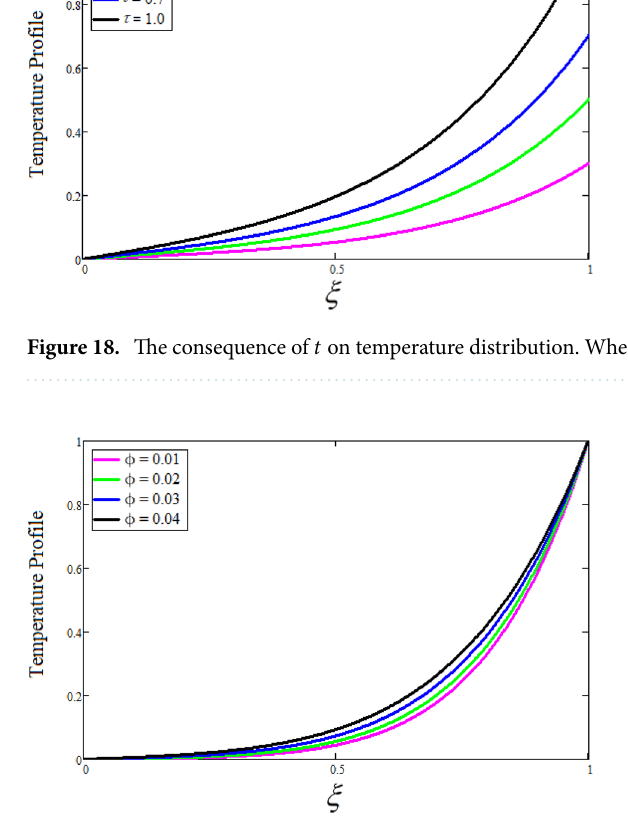
Figure 19. The consequence of φ on temperature distribution. Where α = 0.5, t = 1.